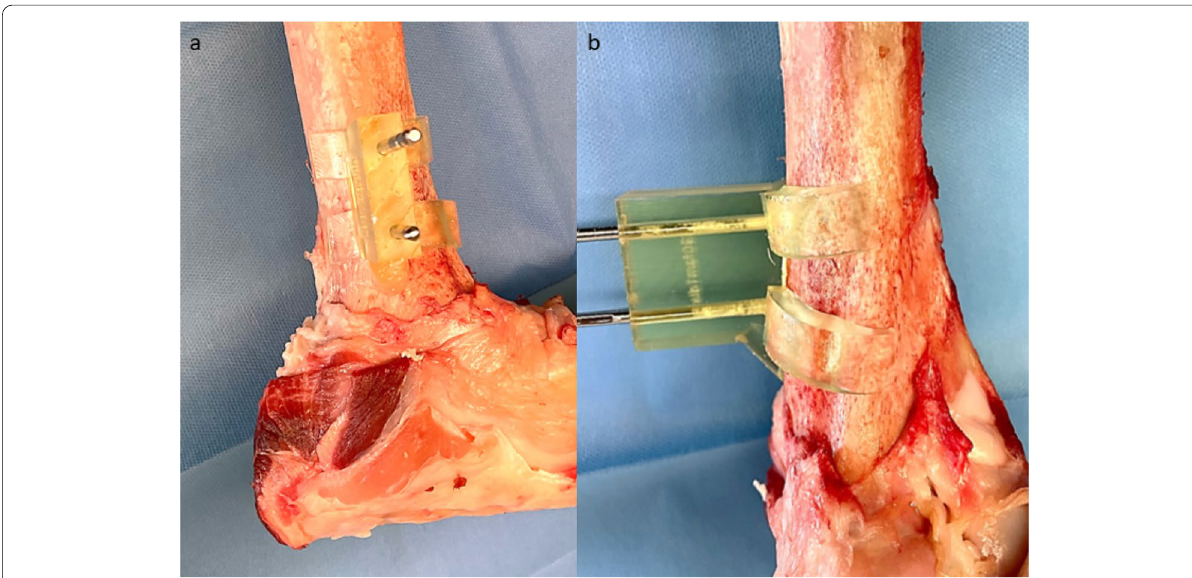
Fig. 3 Femoral surgical site with fitted guide. a shows the first guide fitted to the lateral aspect of the distal femur, fixed with Schanz pins in lateral view. b demonstrates a closer anteromedial view of the anatomical shaped